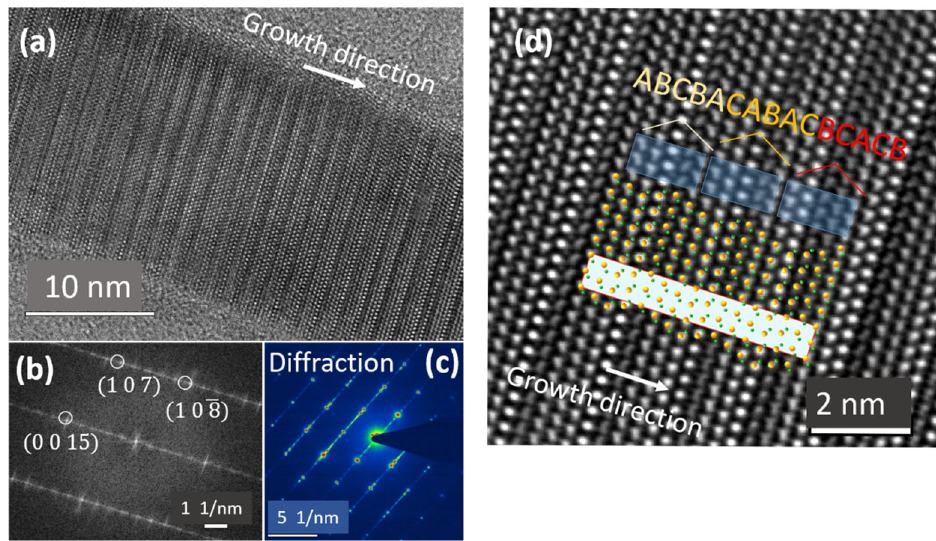
Figure 9. ( a ) HRTEM image of the nanowire, ( b ) the related FFT pattern, ( c ) SAED pattern from a single NW ( d ) Fourier-filtered image superposed with the 15R structure model and the respective stacking sequence ABCBA–CABAC–BCACB. ( a , b , d ) are reprinted with permission from Ref. [17]. Copyright {2021}, Springer Nature.